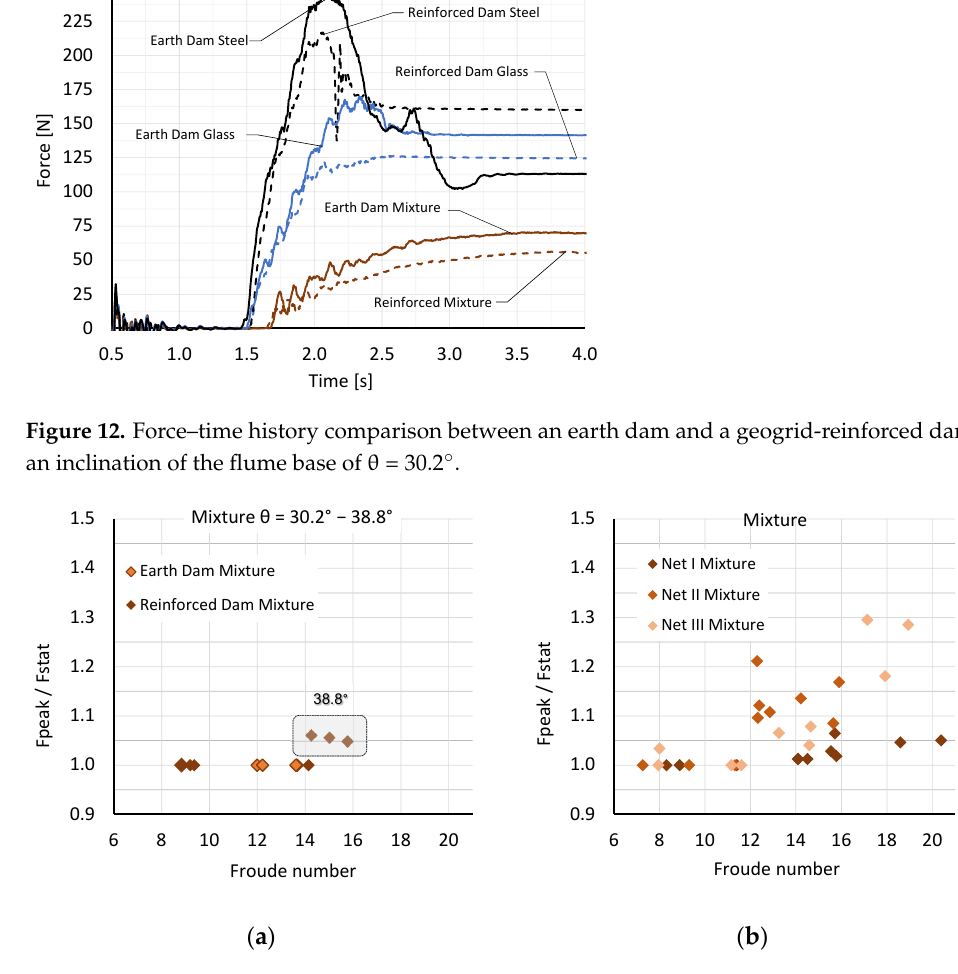
Figure 12. Force–time history c omparison between an earth dam and a geogrid-reinforced dam for an inclination of the flume base of θ = 30.2°.